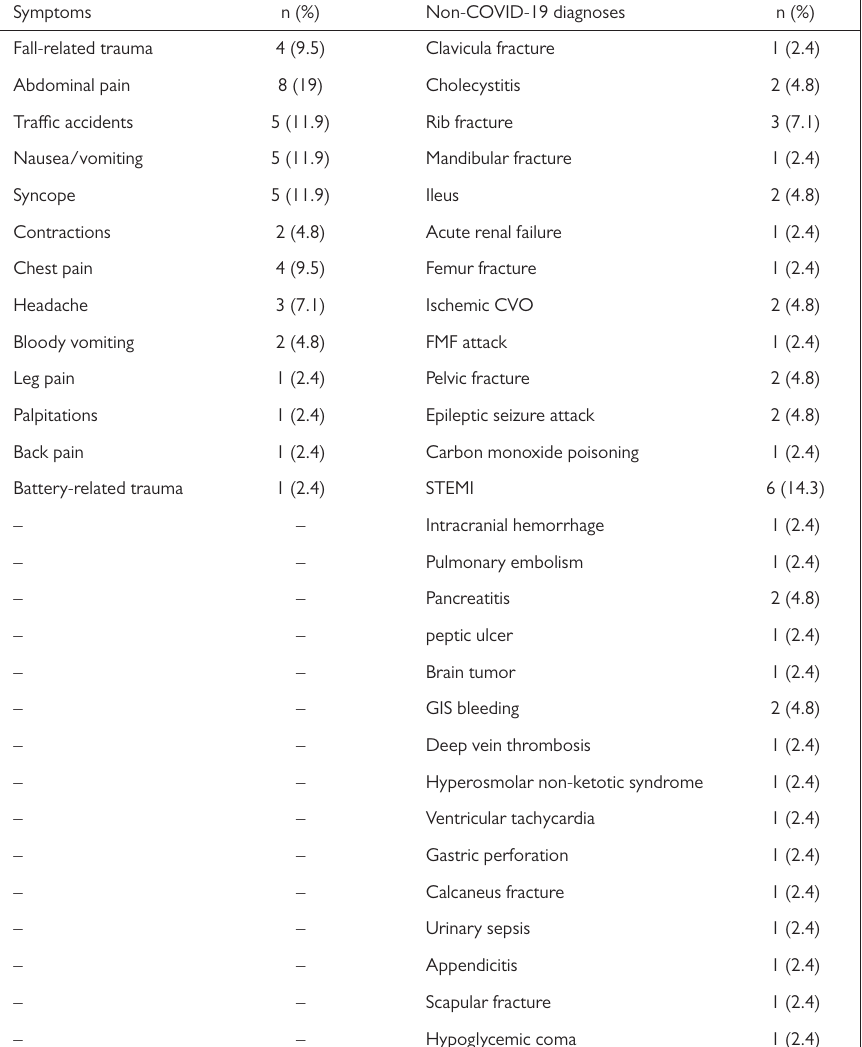
Table 3. Chest CT Findings of Asymptomatic